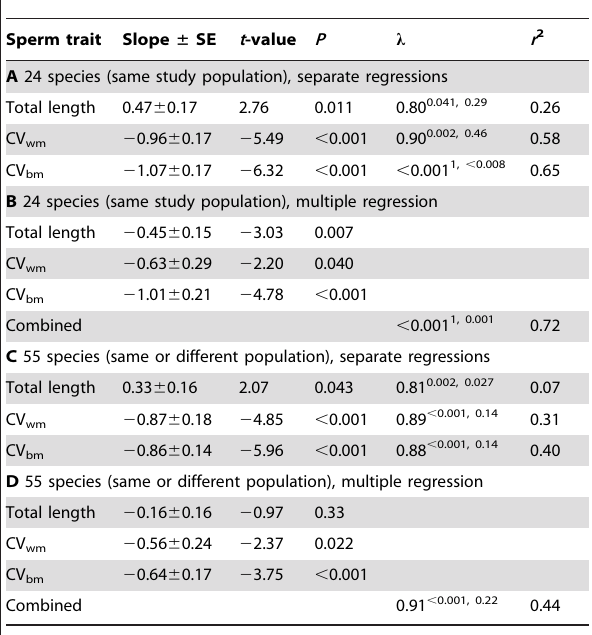
Table 1. Generalised least squares regression analyses of the predictive effects of sperm length traits on the rate of extrapair